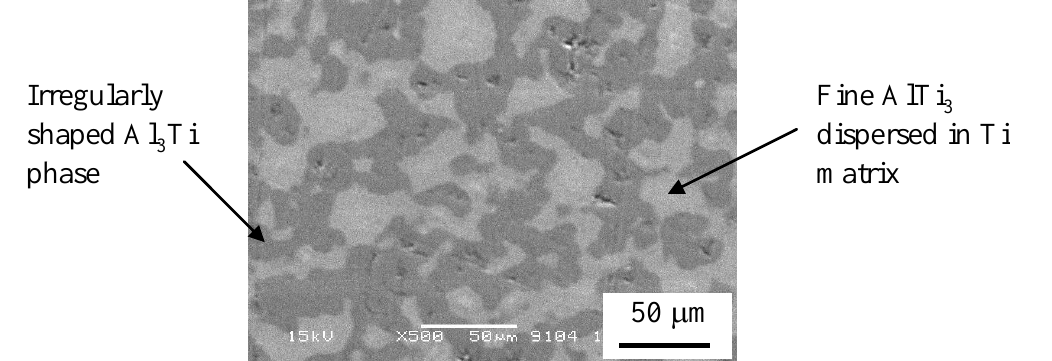
Figure 11. Scanning Electron Microcopy (SEM) images demonstrating the microstructure close to the tip of the specimen processed at 1350 °C